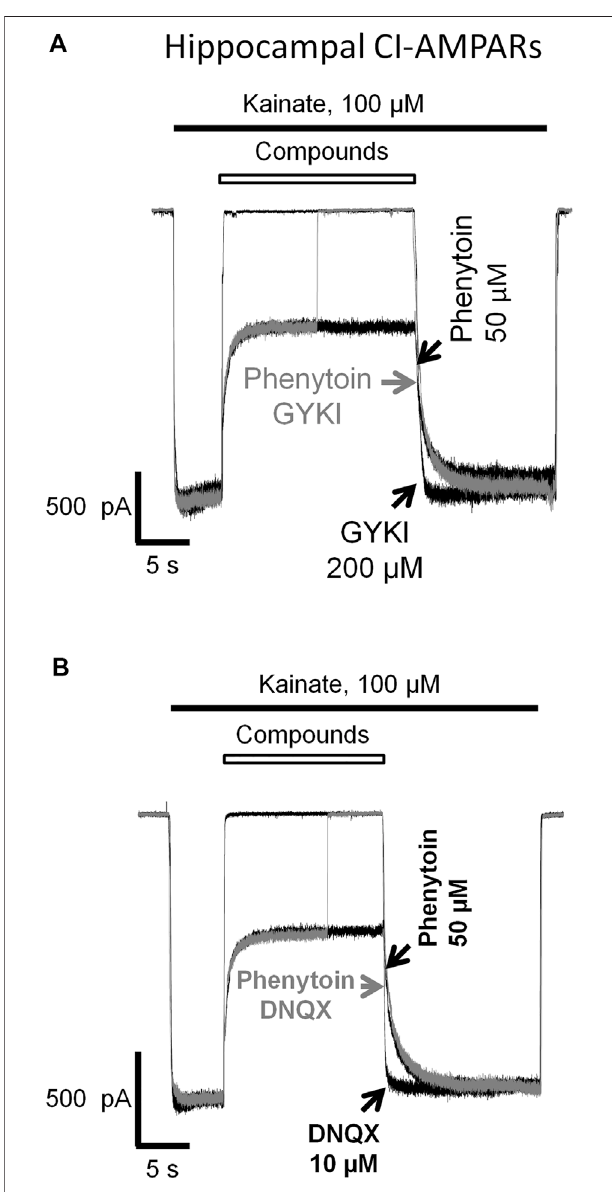
FIGURE 8 | Absence of competition of phenytoin with competitive and negative allosteric AMPA receptor antagonists. The slow phase of recovery from 50 µM phenytoin (black trace) remains unchanged in the presence of 200 µM negative allosteric antagonist GYKI-52466 (A) and 10 µM competitiveantagonistDNQX (B) (graytrace)suggestingthatthesiteofaction of phenytoin is different from that of competitive and negative allosteric AMPAR